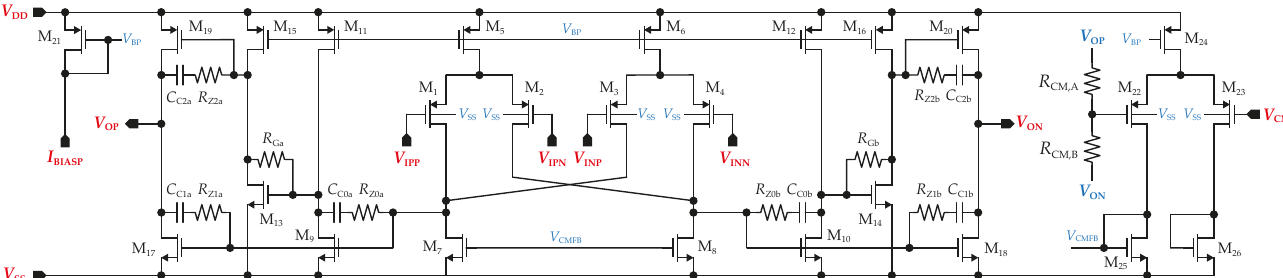
Figure 7. Topology of proposed